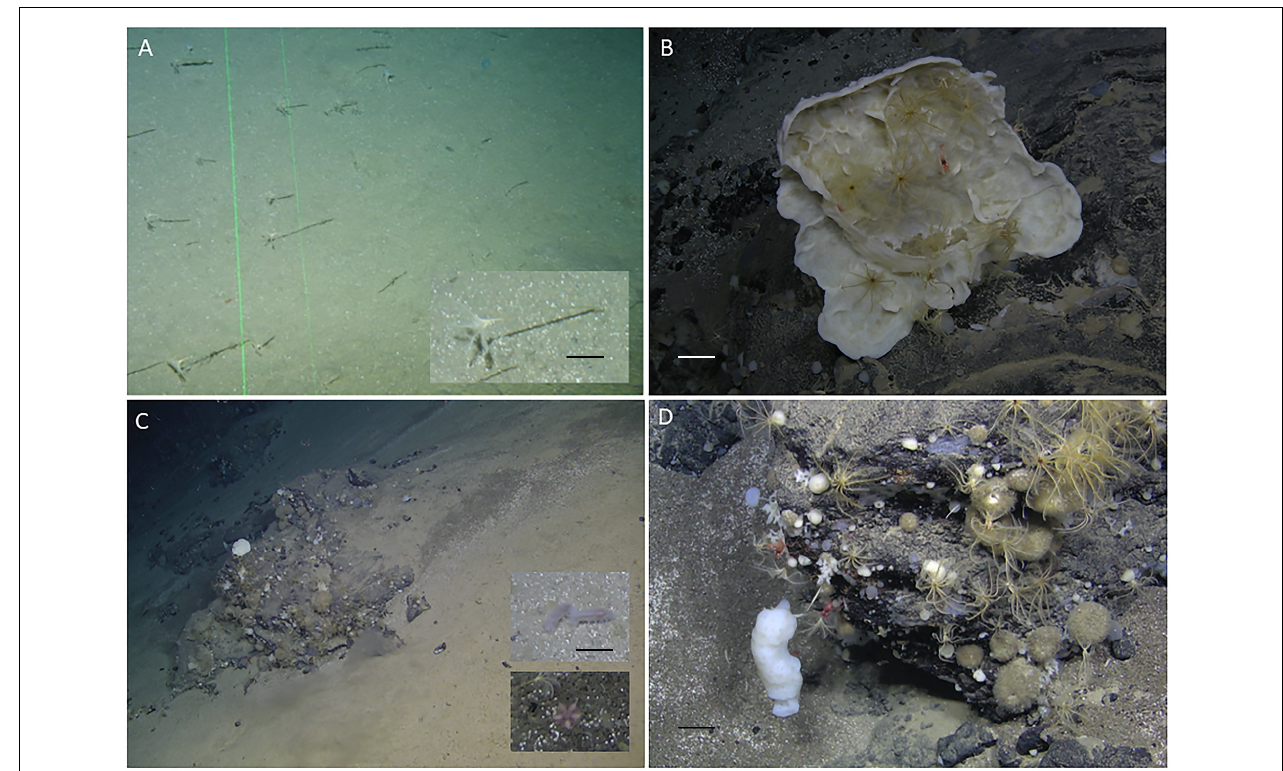
FIGURE 2 | Mohn’s Treasure fauna. (A) Sedimentary plain at Site 1 with dense aggregations of the stalked crinoid Bathycrinus carpenterii . Insert: close-up of one individual (scale bar = 2 cm). (B) Rocky outcrop with sponges and associated fauna on Site 2 (scale bar = 10 cm). (C) Site 3 was dominated by fine sediments with holothurians and asteroids as well as rocky outcrops with sponges. The insert shows the holothurian Kolga species and the asteroid Hymenaster pellucidu s (scale bar = 5 cm). (D) Site 4 was dominated by hard substrates with high abundance of filter feeders, in particular sponges (scale bar = 10 cm).